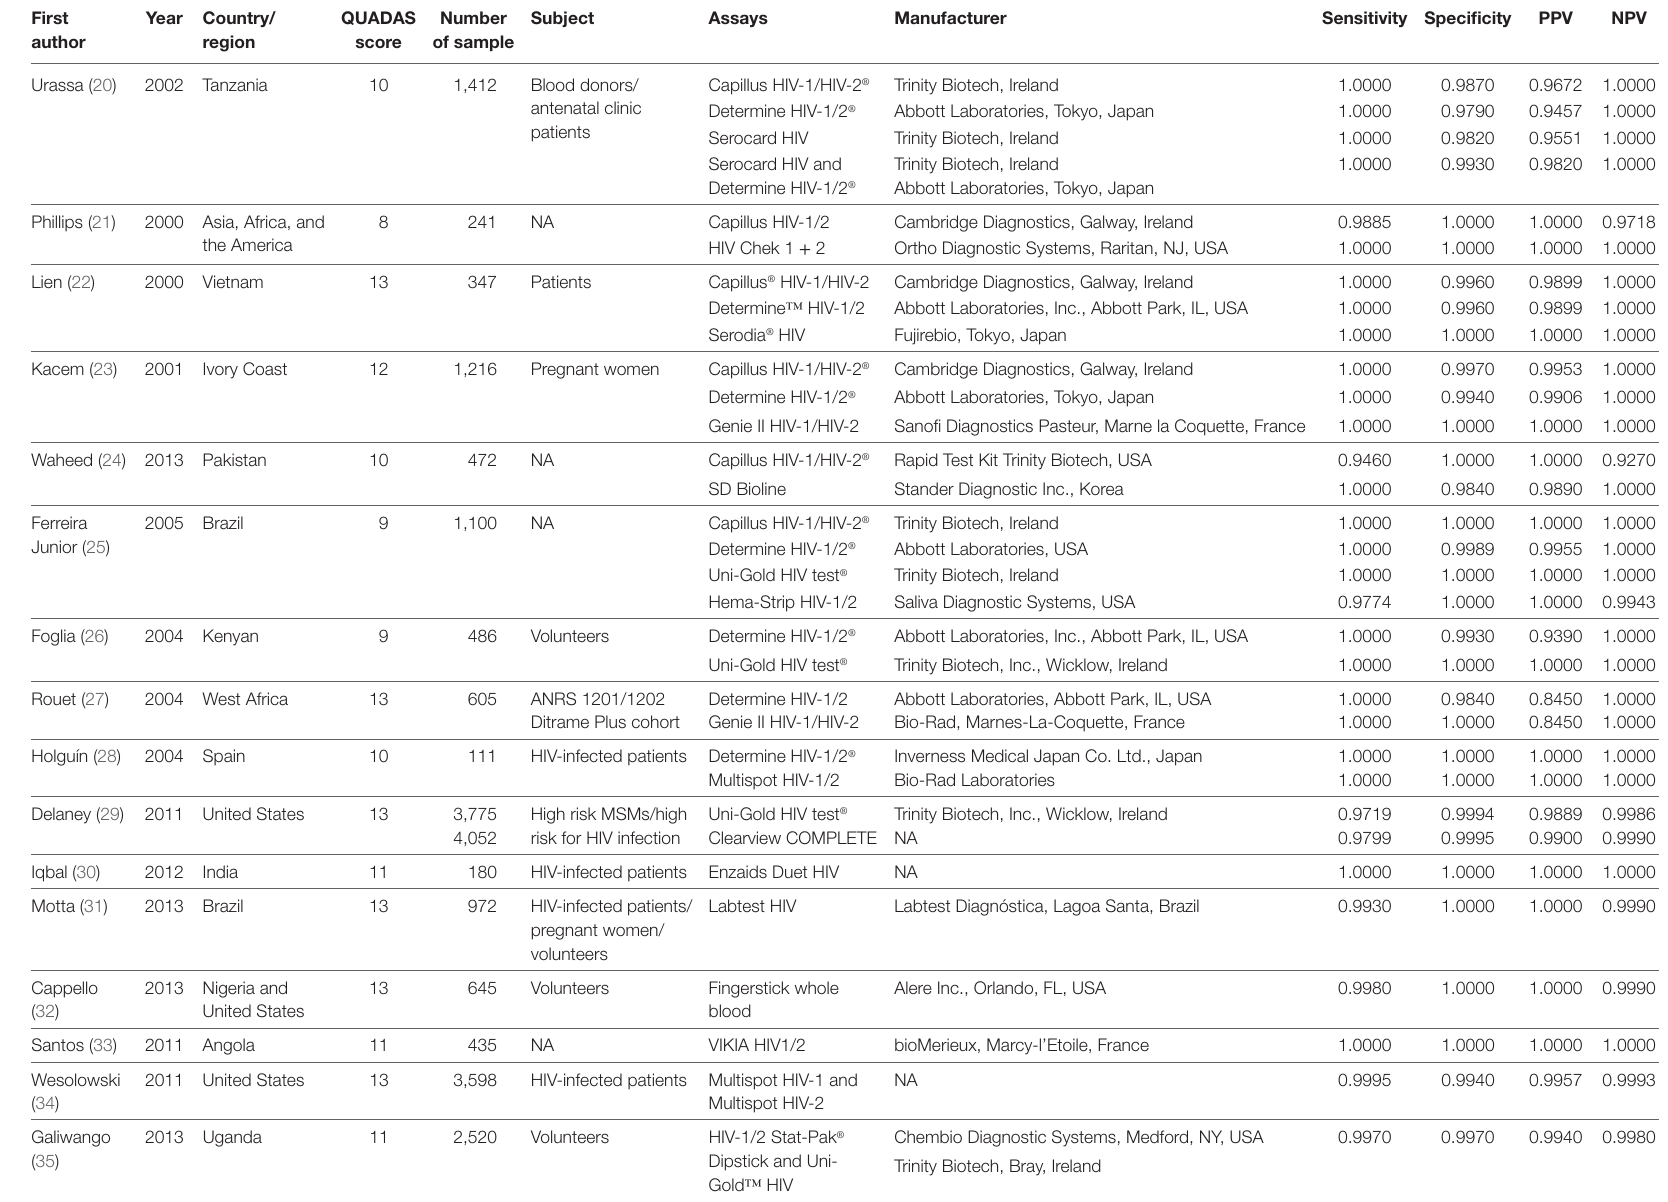
taBLe 1 | Characteristics and outcomes of studies included in the